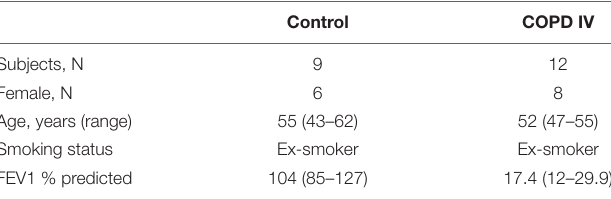
TABLE 1 | Characteristics of the subjects from whom lung tissue was